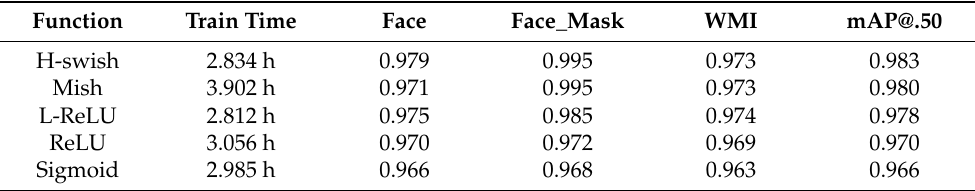
Table 11. Influence of different activation functions.